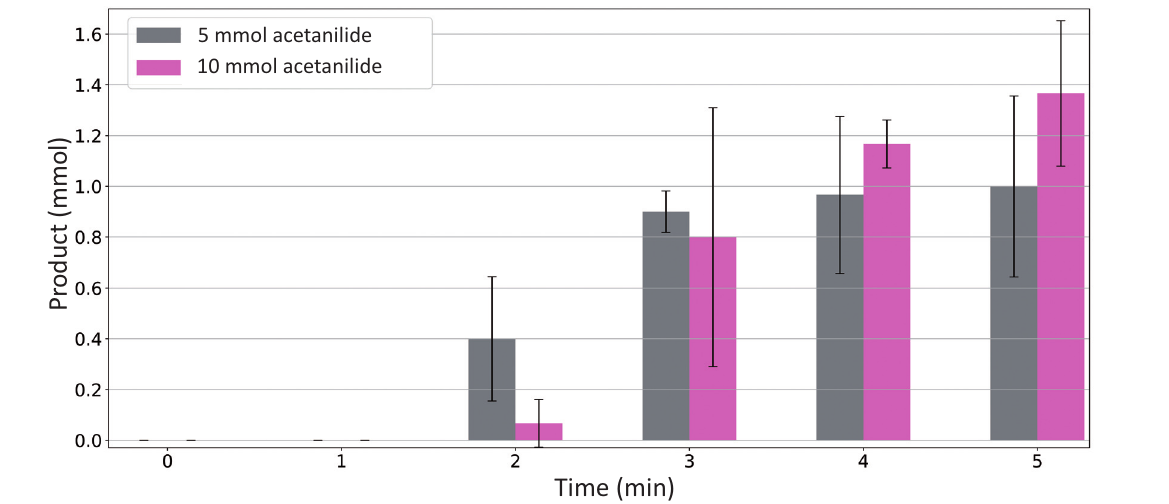
Fig. 2. Bromination of different initial amounts (5 or 10 mmol) of acetanilide in the presence of 5.5 mmol KNO 3 and at continuous flow of gaseous HBr. The error bars were calculated from triplicate experiments.